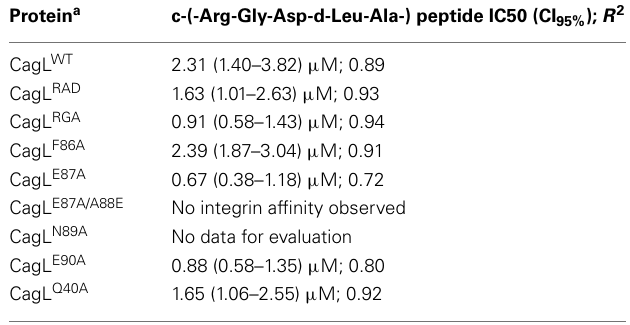
Table 4 | Inhibition ofWM-115 cell adhesion to CagL mutants by c-(-RGDlA-) a